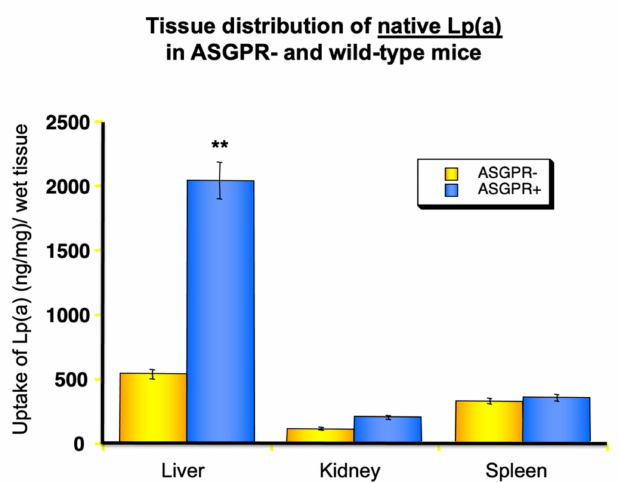
Figure 9. Impact of the asialoglycoprotein receptor (ASGPR) on the uptake of Lp(a) into different organs. Lp(a) was treated with neuraminidase to transform it into asialo-Lp(a), labelled with I 125 and injected into wild-type mice or transgenic mice lacking the ASGPR (ASGPR-). After 4 h, mice were sacrificed, and the radioactivity found in different organs was measured. Asialo-Lp(a) is primarily taken up by the liver. In addition, Lp(a) from human serum incubated for 24 h at 37 ◦ C in the absence of neuraminidase showed an increased uptake into the liver in comparison to fresh Lp(a) (experiments not shown) [24]. ** p <